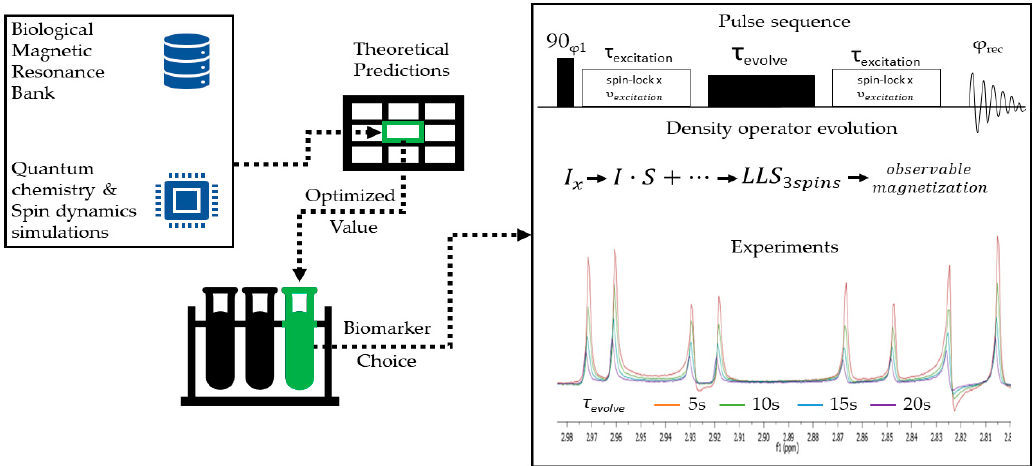
Figure 3. Schematic representation of the methodology developed for choosing molecules suited to sustain long-lived states with lifetimes comparable to those of metabolic conversions in vivo. First, the investigated molecules were evaluated from a theoretical point of view by simulating the corresponding spin systems. Magnetic parameters were extracted from data banks and atomic coordinates from quantum-chemistry simulations. Then, the system’s Liouvillian was computed and diagonalized. The eigenstate with the smallest non-zero eigenvalue was identified as the system’s longest-lived state. The best-suited molecules were then chosen for experiments and the a priori computed lifetimes were compared to experimental lifetimes measured using an NMR spectrometer.